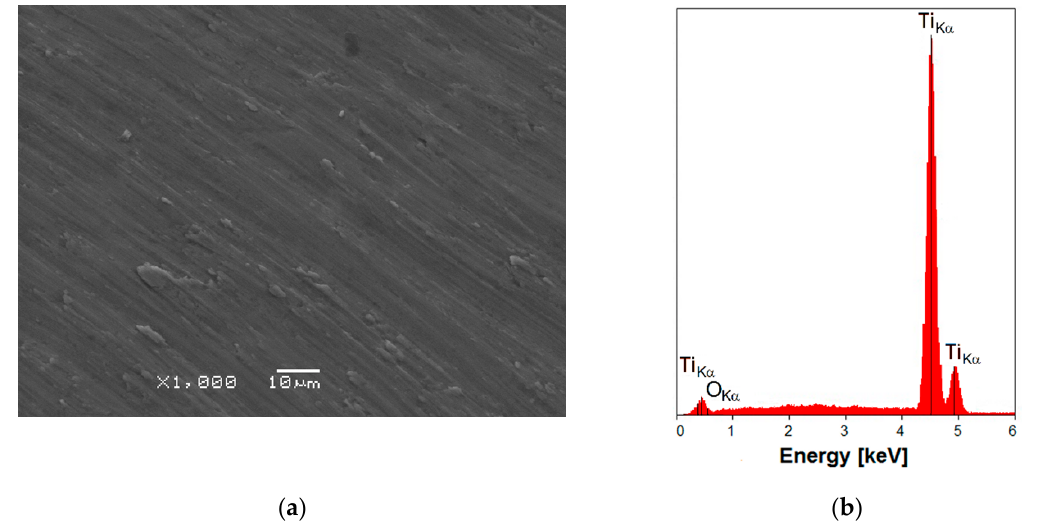
Figure 2. ( a ) SEM image of the Ti G4 machine surface; ( b ) EDS spectrum in the micro-region of the machine surface.